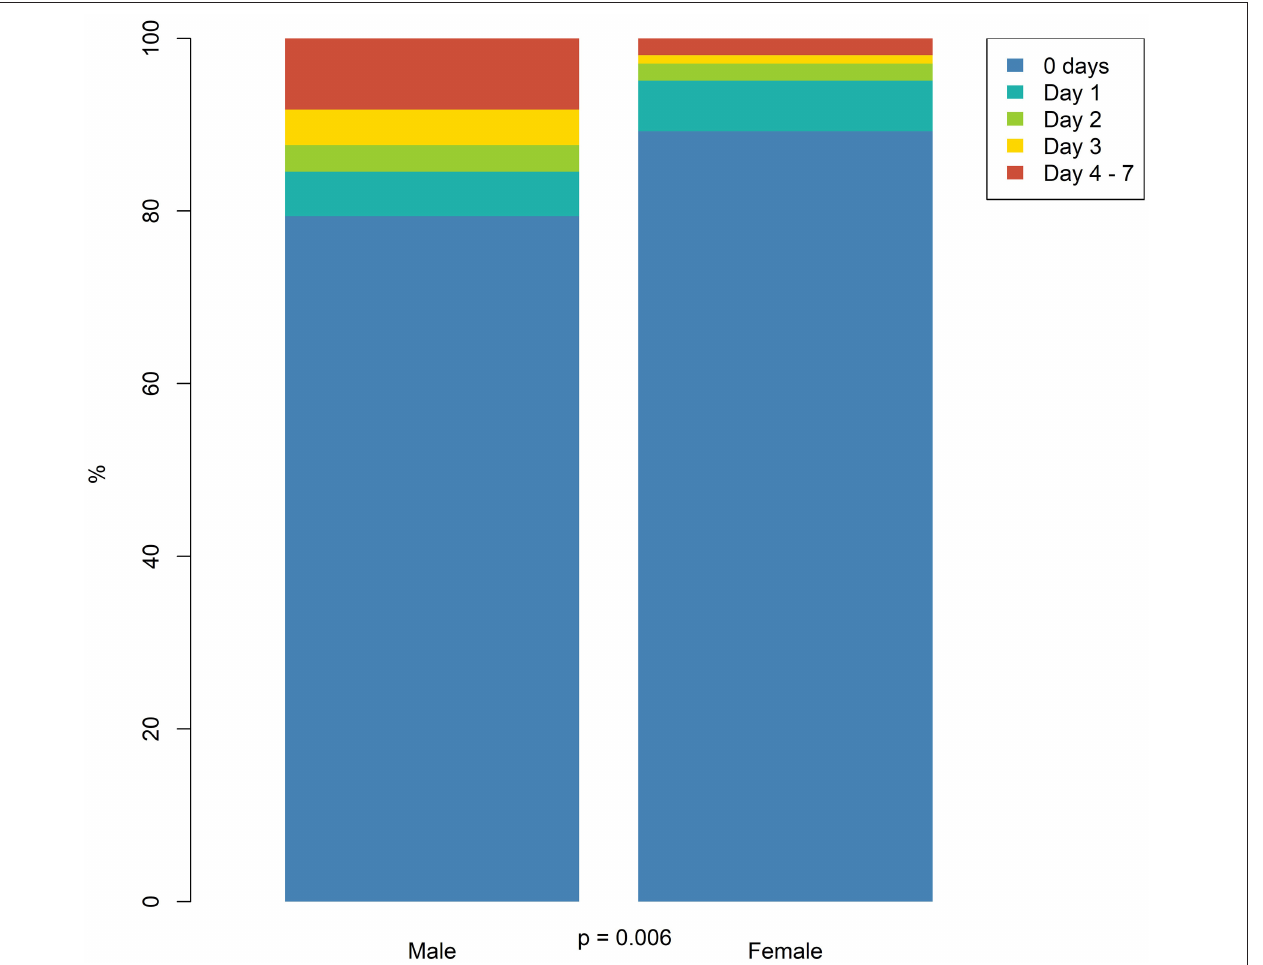
FIGURE 5 | Time from admission to do-not-resuscitate (DNR) within the first week.